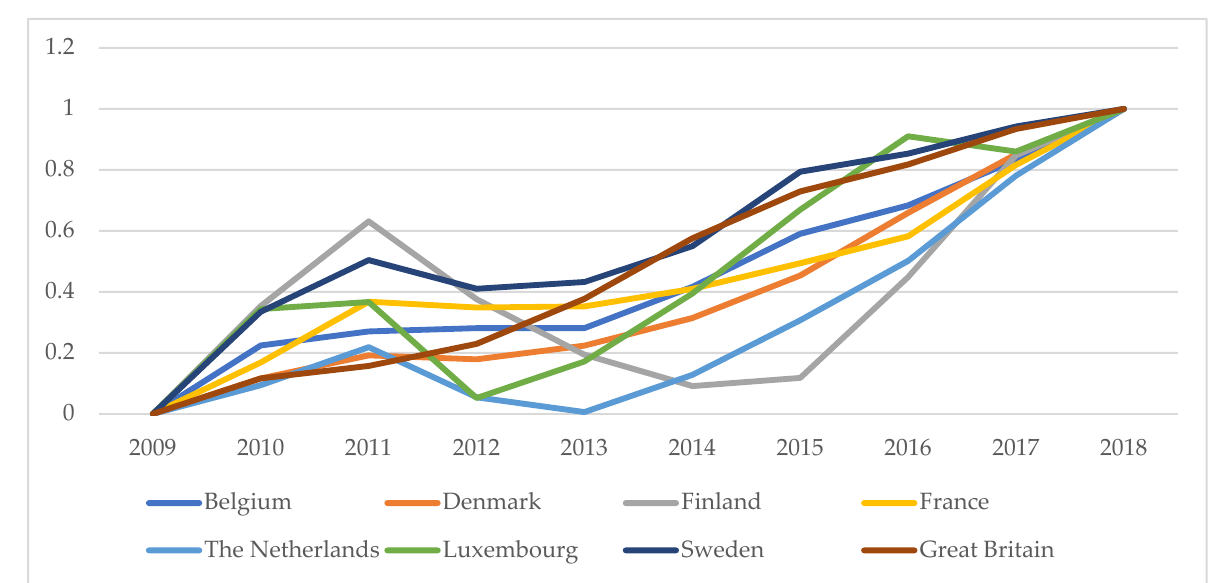
Figure A1. Trends in air transport in 2009–2018, TOPSIS value index. Source: Reproduced from [16], Eurostat: 2009—2018.